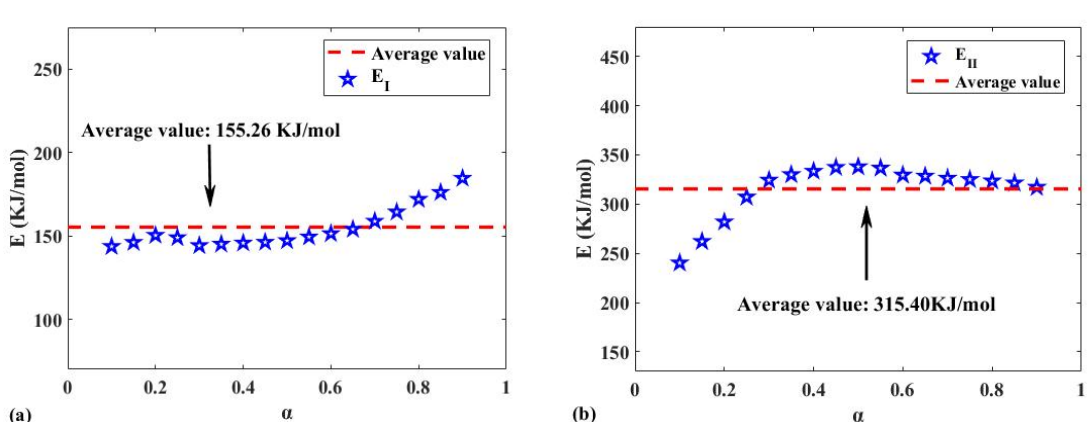
Figure 4. ( a ) The E – α diagram of Reaction I based on Figure 2c; ( b ) the E – α diagram of Reaction II based on Figure